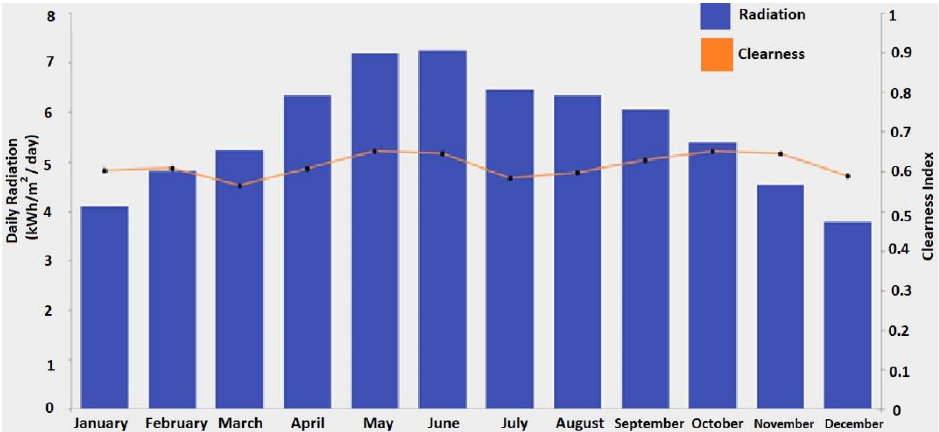
Figure 2. Daily radiation amount at Yas Island .